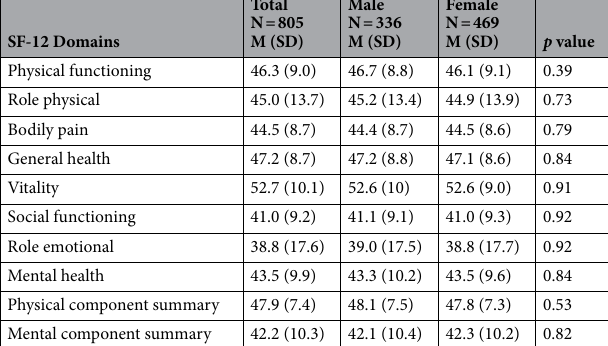
Table 4. SF-12v2 summary scores. M: Mean; SD: Standard